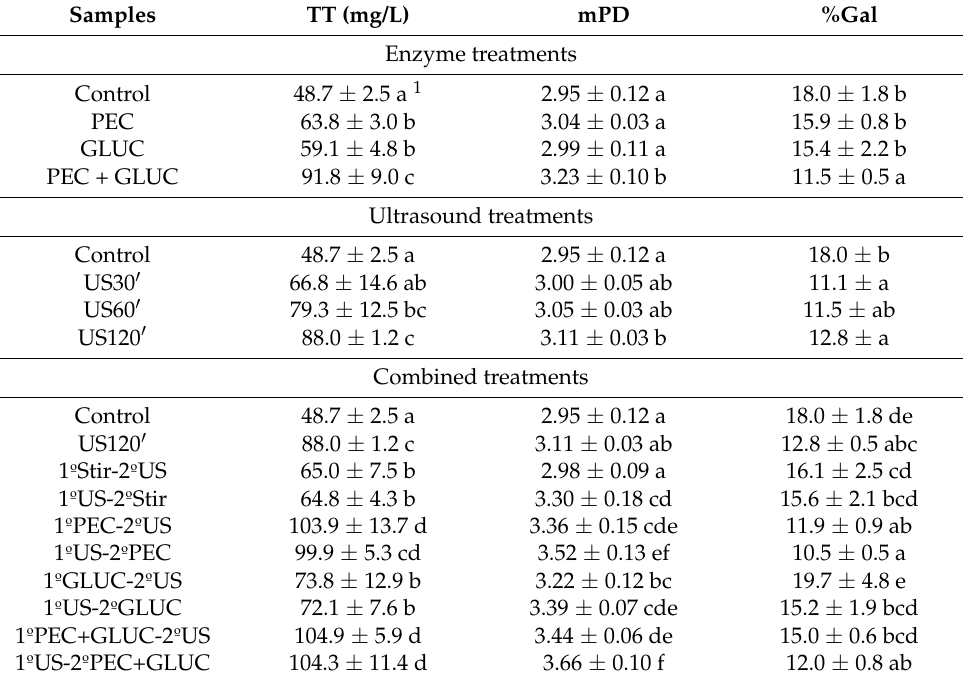
Table 1. Effect of the addition of enzymes and application of ultrasound in the release of anthocyanins from red wine lees. Characterization and quantification of anthocyanins in solution (µg/g ± standard deviation). Different letters in the same column mean statistically significant differences ( p ≤ 0.05) ( n = 3).